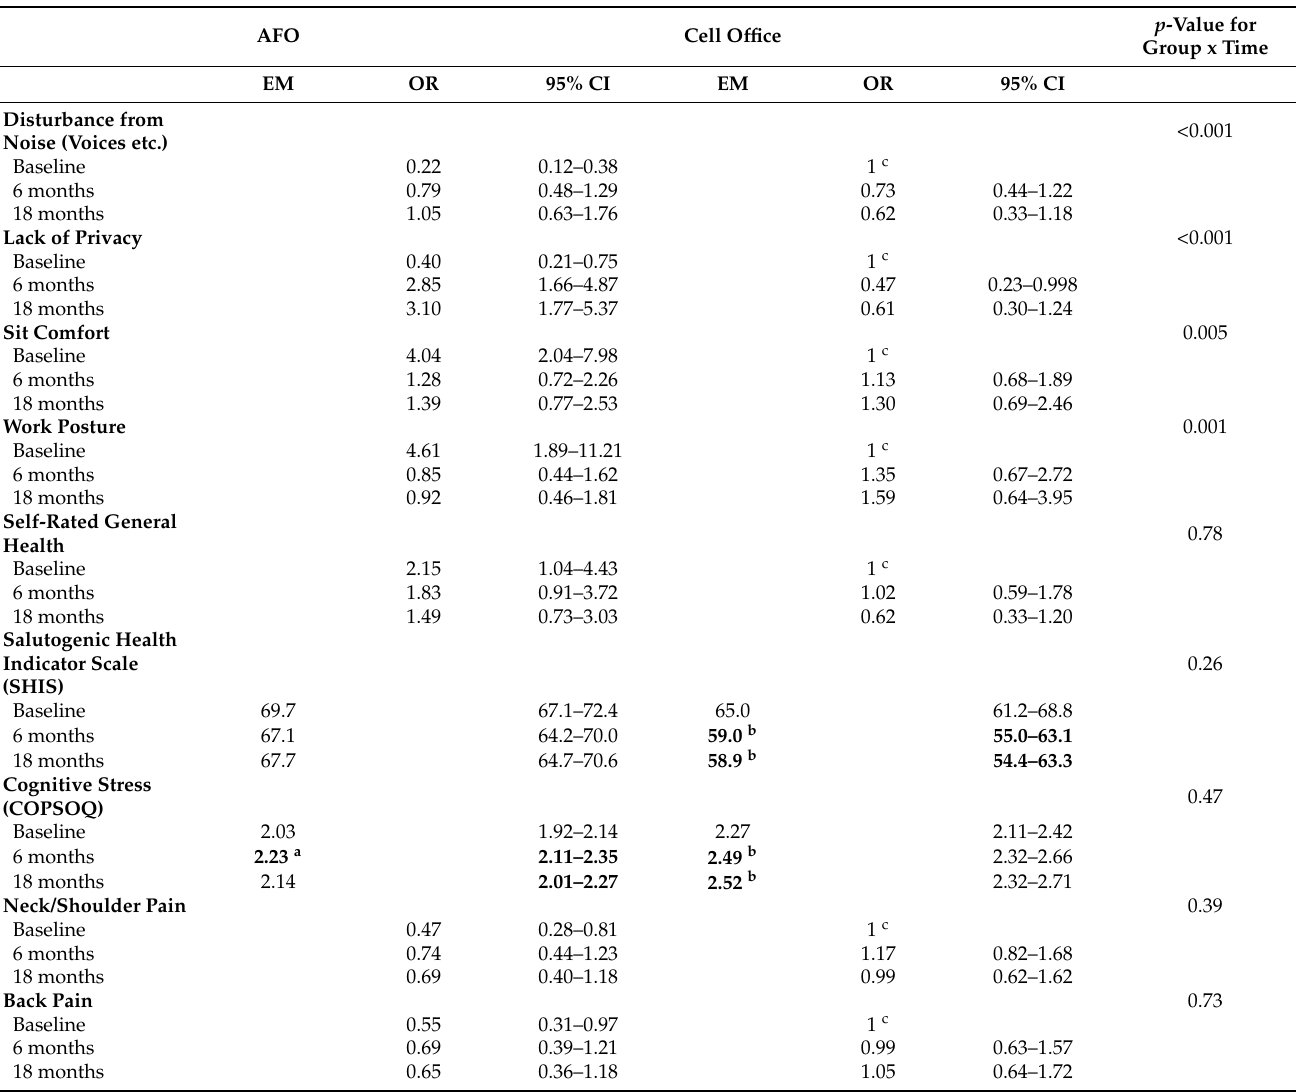
p -Value for Group x Time